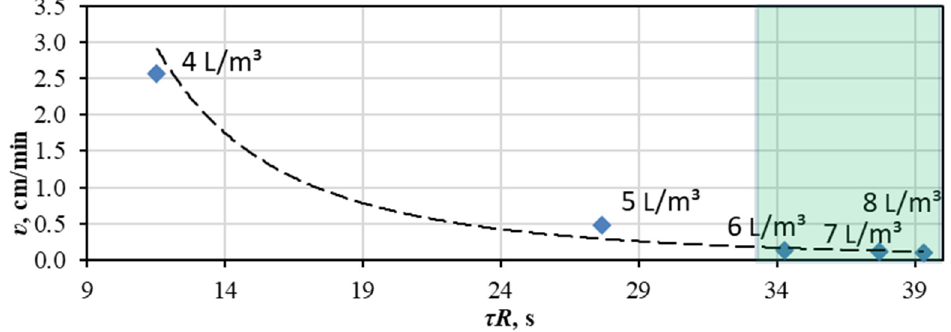
Figure 5. Dependence of the proppant settling rate on the relaxation time of liquid based on syn- thetic polymer.